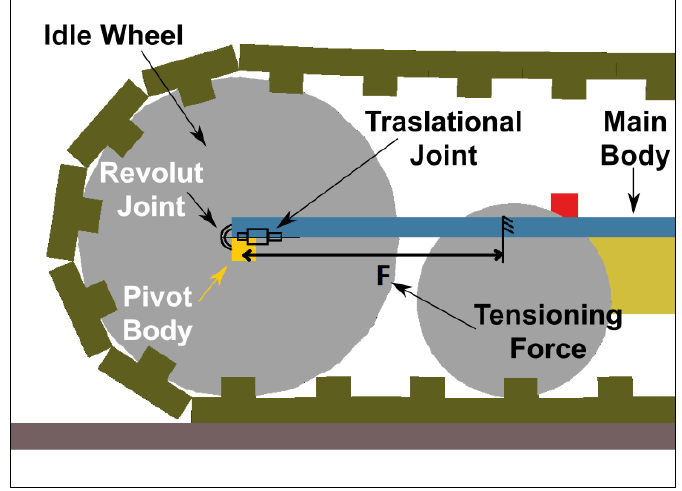
Figure 7. Tensioning